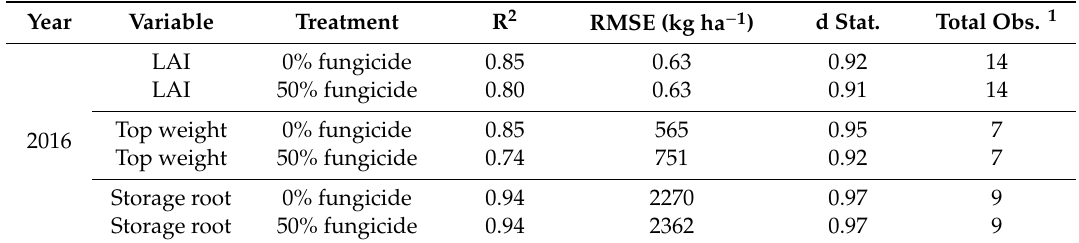
Table 5. Detailed statistics for simulated and observed values of LAI (m 2 m − 2 ), top weight (DM) kg ha − 1 and storage root weight (DM) kg ha − 1 for the evaluation treatments 0% and 50% fungicide in 2016.